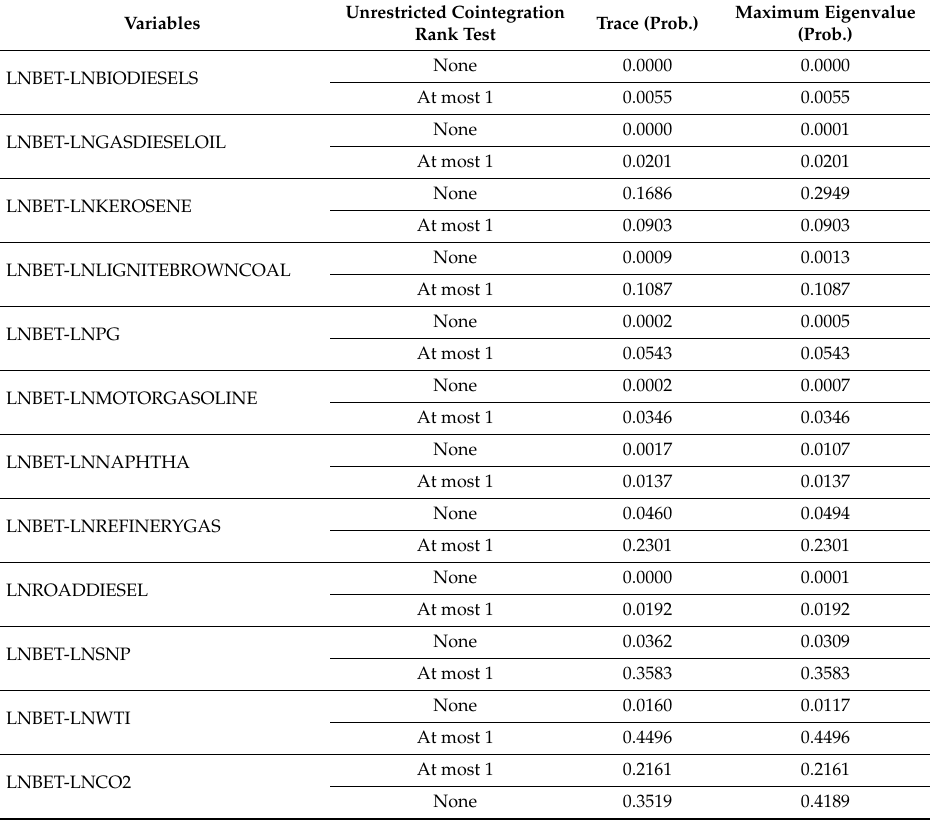
Table 7. The results of the Johansen test.